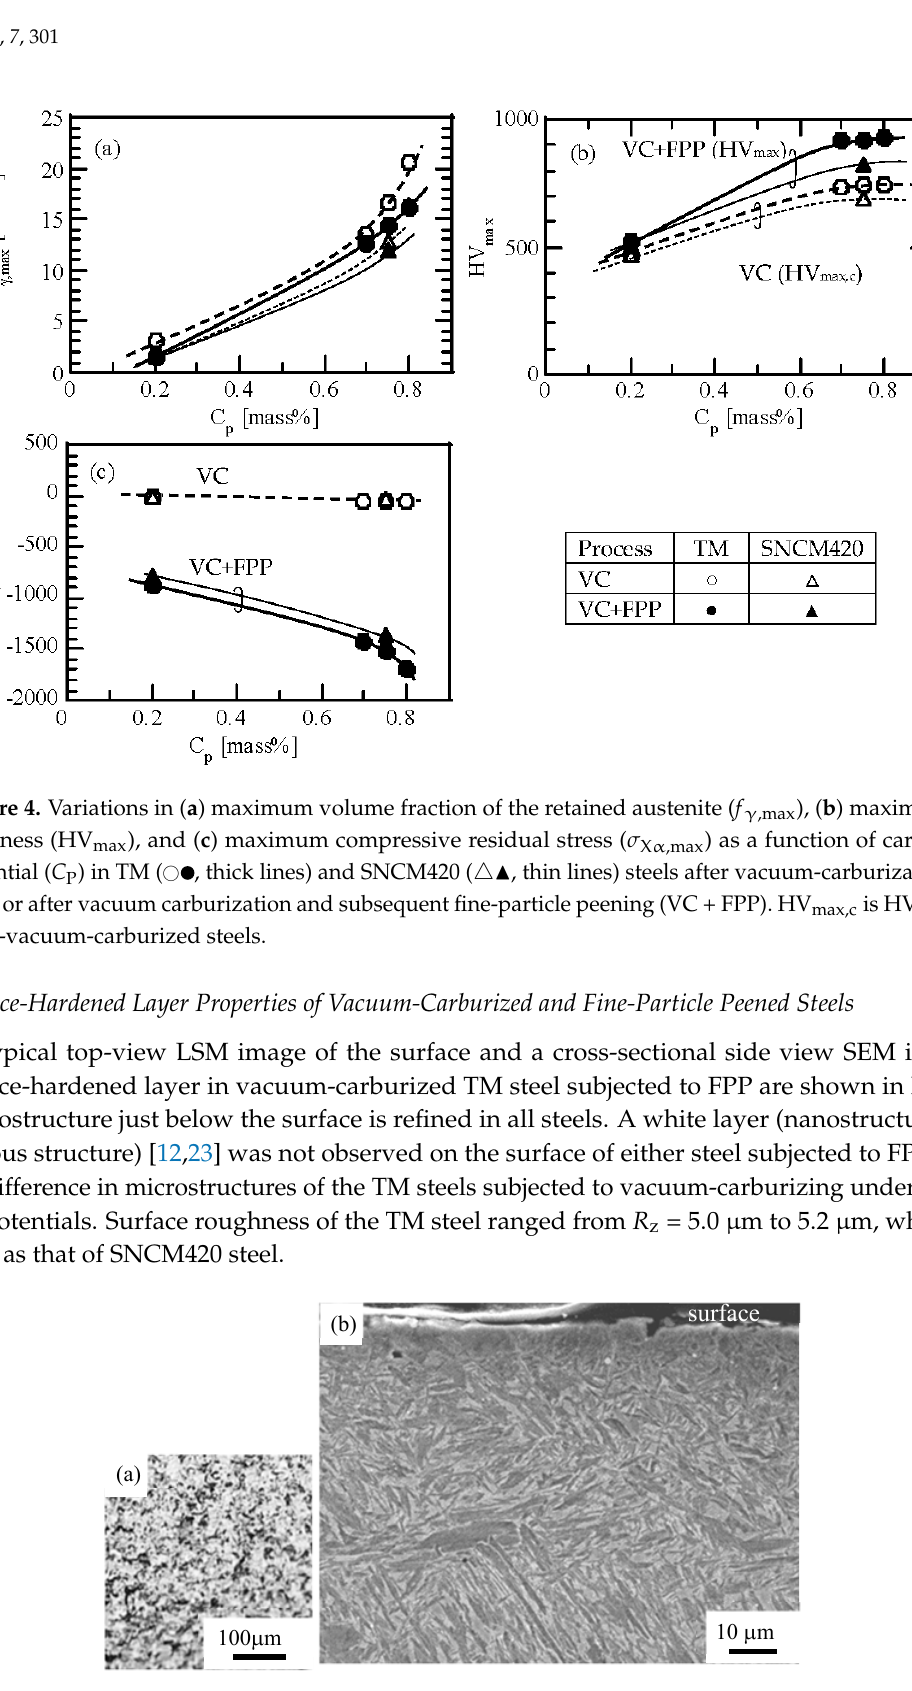
Figure 5. Typical ( a ) laser scanning microscopy (LSM) image of the top-view of the surface and ( b ) SEM image of the cross-sectional side view of the surface-hardened layer of the TM steel subjected to vacuum-carburization under a carbon potential of 0.8 mass % and subsequent fine-particle